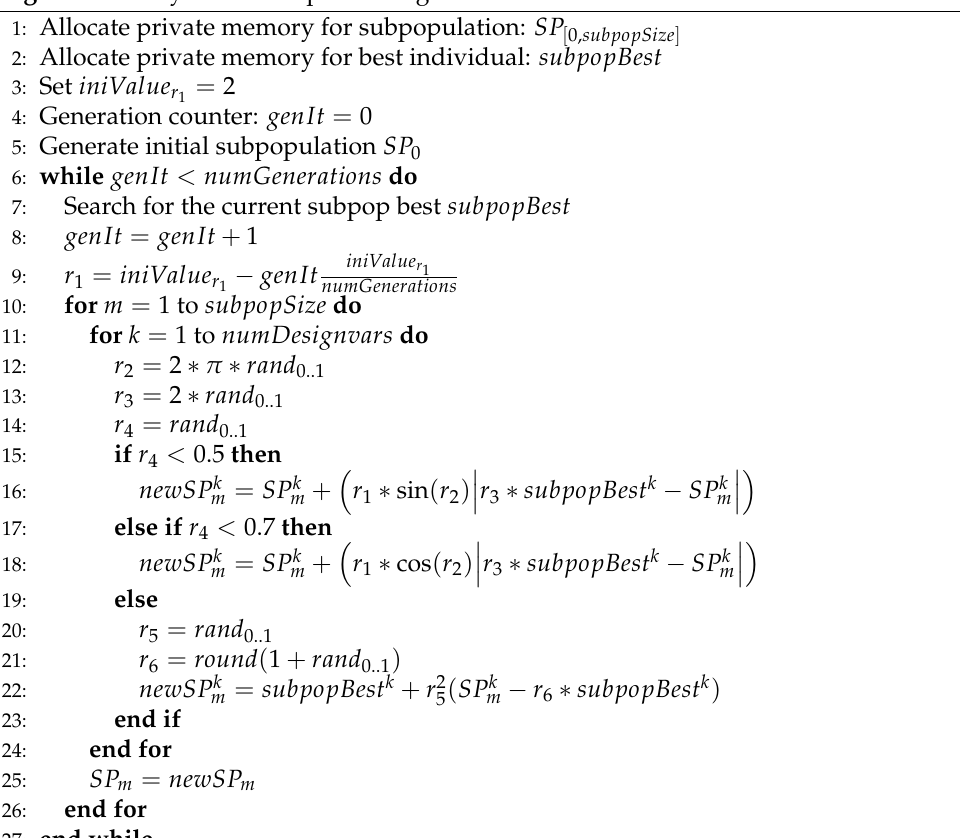
Algorithm 4 Asynchronous parallel